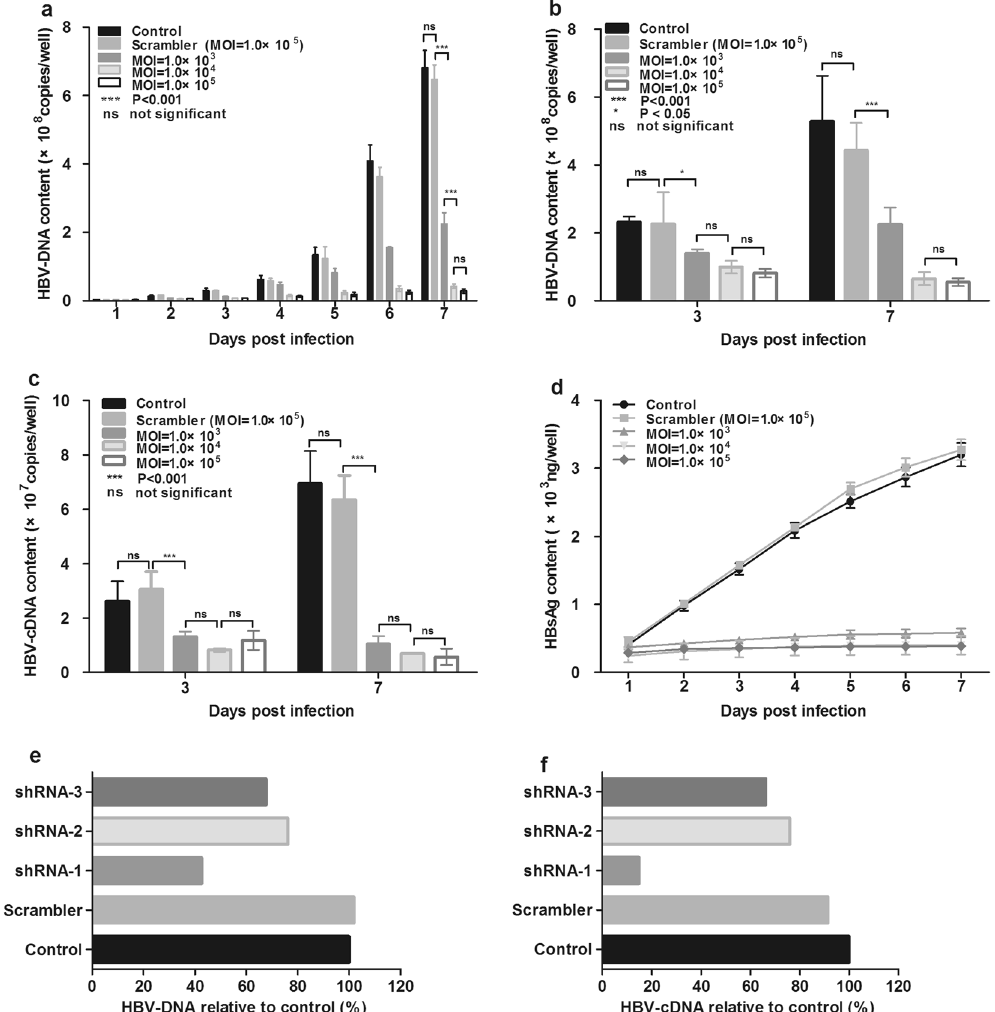
Figure 2. AAV-shRNA-1 inhibits HBV replication, transcription, and HBsAg expression in HepG2.2.15 cells. HepG2.2.15 cells were infected with AAV2-shRNA-1 at a multiplicity of infection (MOI) of 1000, 10000, and 100000. Supernatants and cells were collected separately at the indicated time points post infection. Changes of HBV DNA in supernatants ( a ) and cells ( b ), HBV RNA in cells ( c ), and HBsAg in supernatants ( d ) were monitored during a 7 day period. The inhibitory effects of different AAV-shRNAs at an MOI of 1000 on HBV DNA ( e ) or HBV RNA ( f ) were estimated by the amount of HBV DNA or HBV RNA after each treatment relative to that of the control (%). Control, PBS treatment; scrambler, vector containing the shRNA sequence not targeted to the HBV genome. P < 0.001: significant difference. Ns: the difference was not significant. Data represent the mean ± SD of three independent